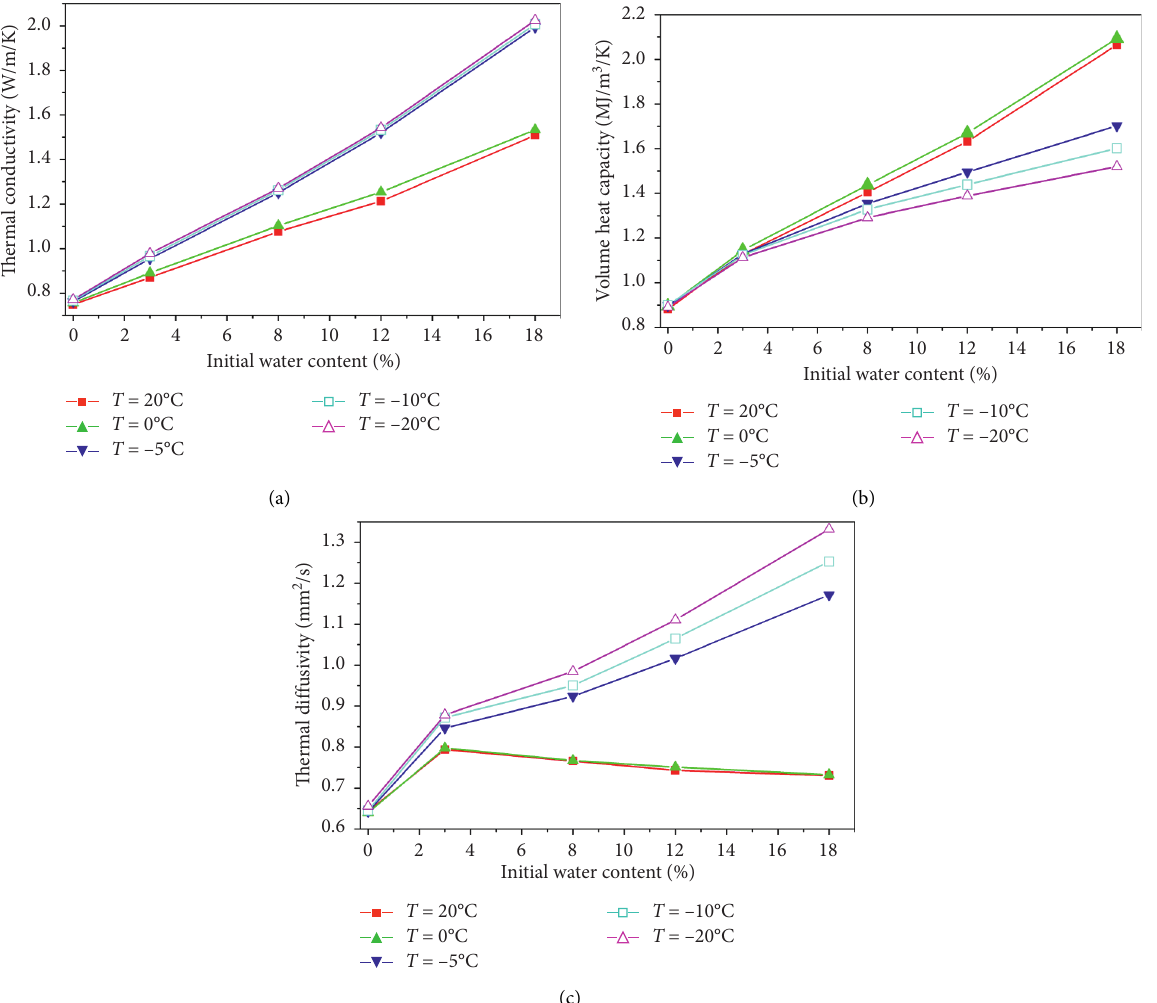
Figure 5: Thermal properties versus initial water content for soils under different temperatures. (a) Thermal conductivity, (b) volumetric heat capacity, and (c) thermal